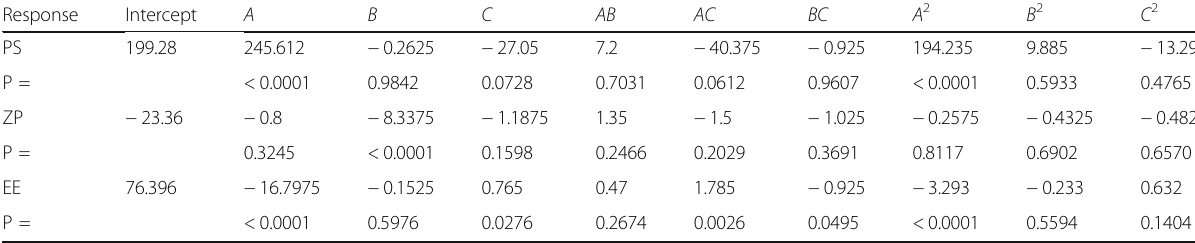
Table 2 Coefficient table for effect of independent variable on dependent variable Response